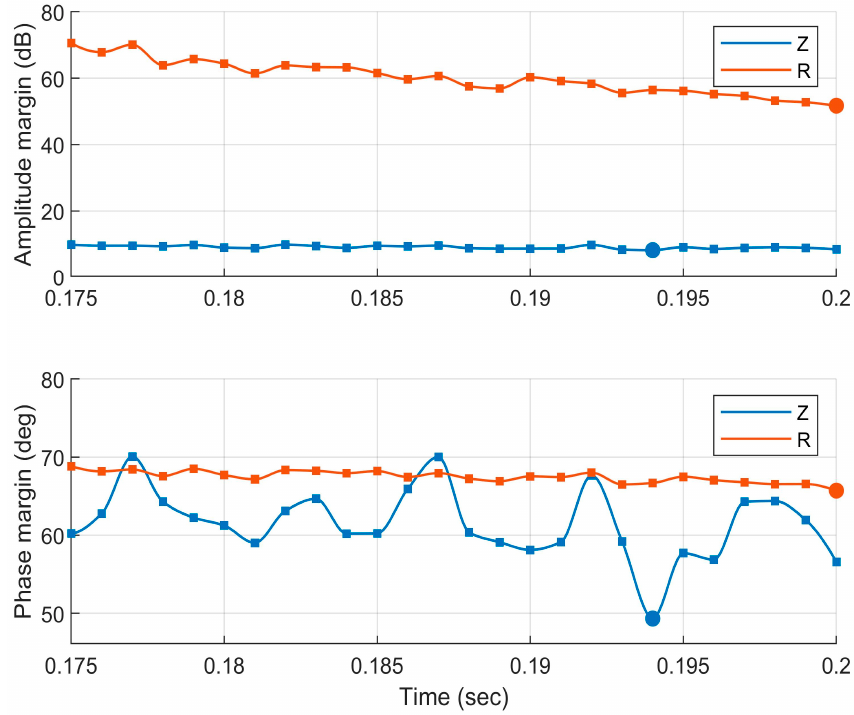
Figure 4. Set of Nichols diagrams of an open-loop system with plasma models corresponding to different moments in time with PID-controllers tuned with QFT.